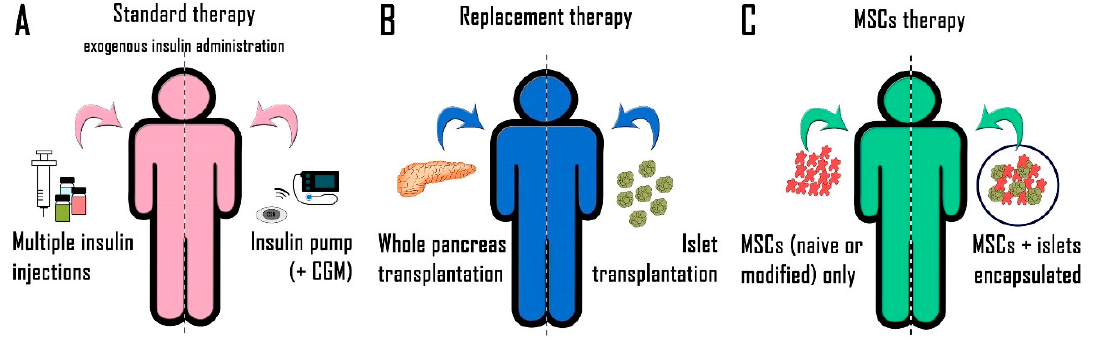
Figure 1. A schematic representation of current or proposed therapies for diabetes. ( A ) The standard therapy for diabetes, based on exogenous insulin administration by multiple injections or insulin pump. ( B ) The therapies based on the replacement of pancreatic islets, either by whole pancreas transplantation or by isolated islet transplantation. ( C ) The new therapies based on MSCs (mesenchymal stem cells). Given alone or encapsulated into 3D structures together with pancreatic